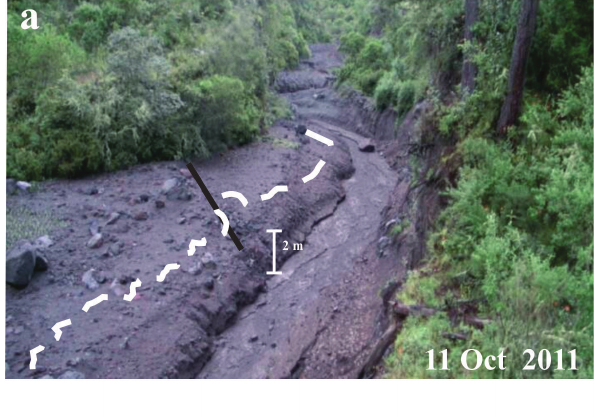
Table 4. Arrival times of peak III and IV using different CN